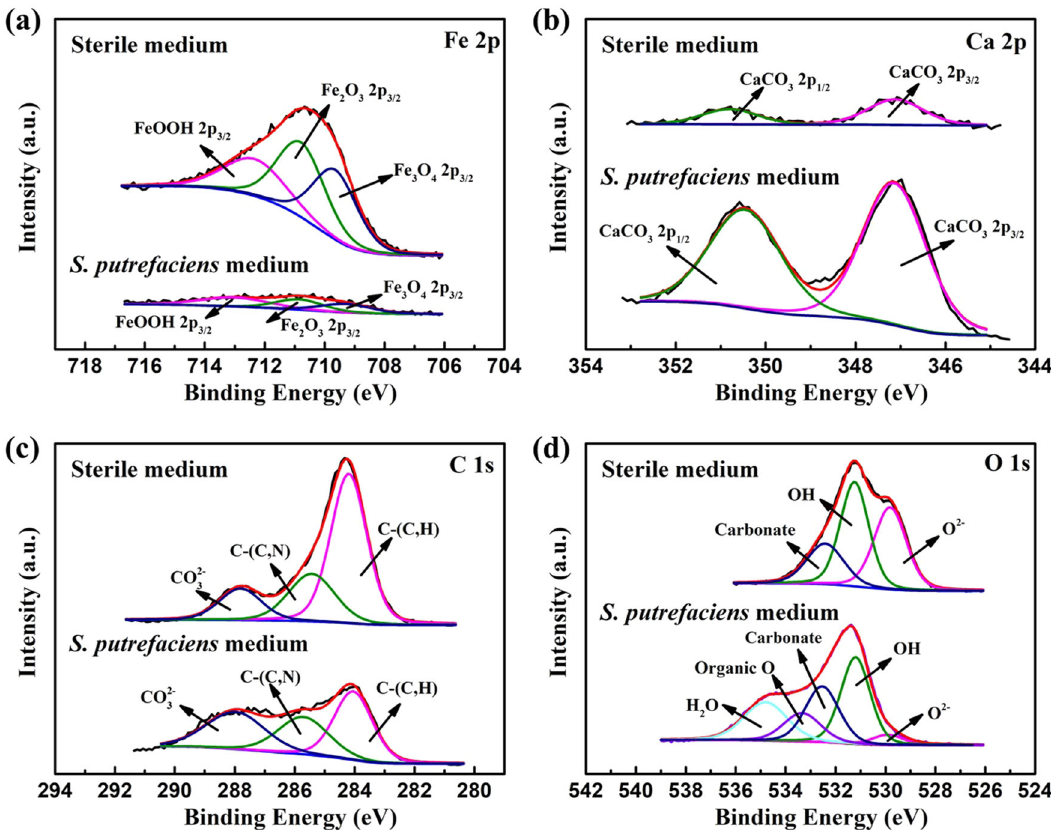
Fig. 6 High-resolution XPS spectra for the Q235 surface after immersion in sterile medium and in S. putrefaciens -inoculated medium for 14 days. a – d correspond to Fe 2p , Ca 2p , C 1s , and O 1s ,